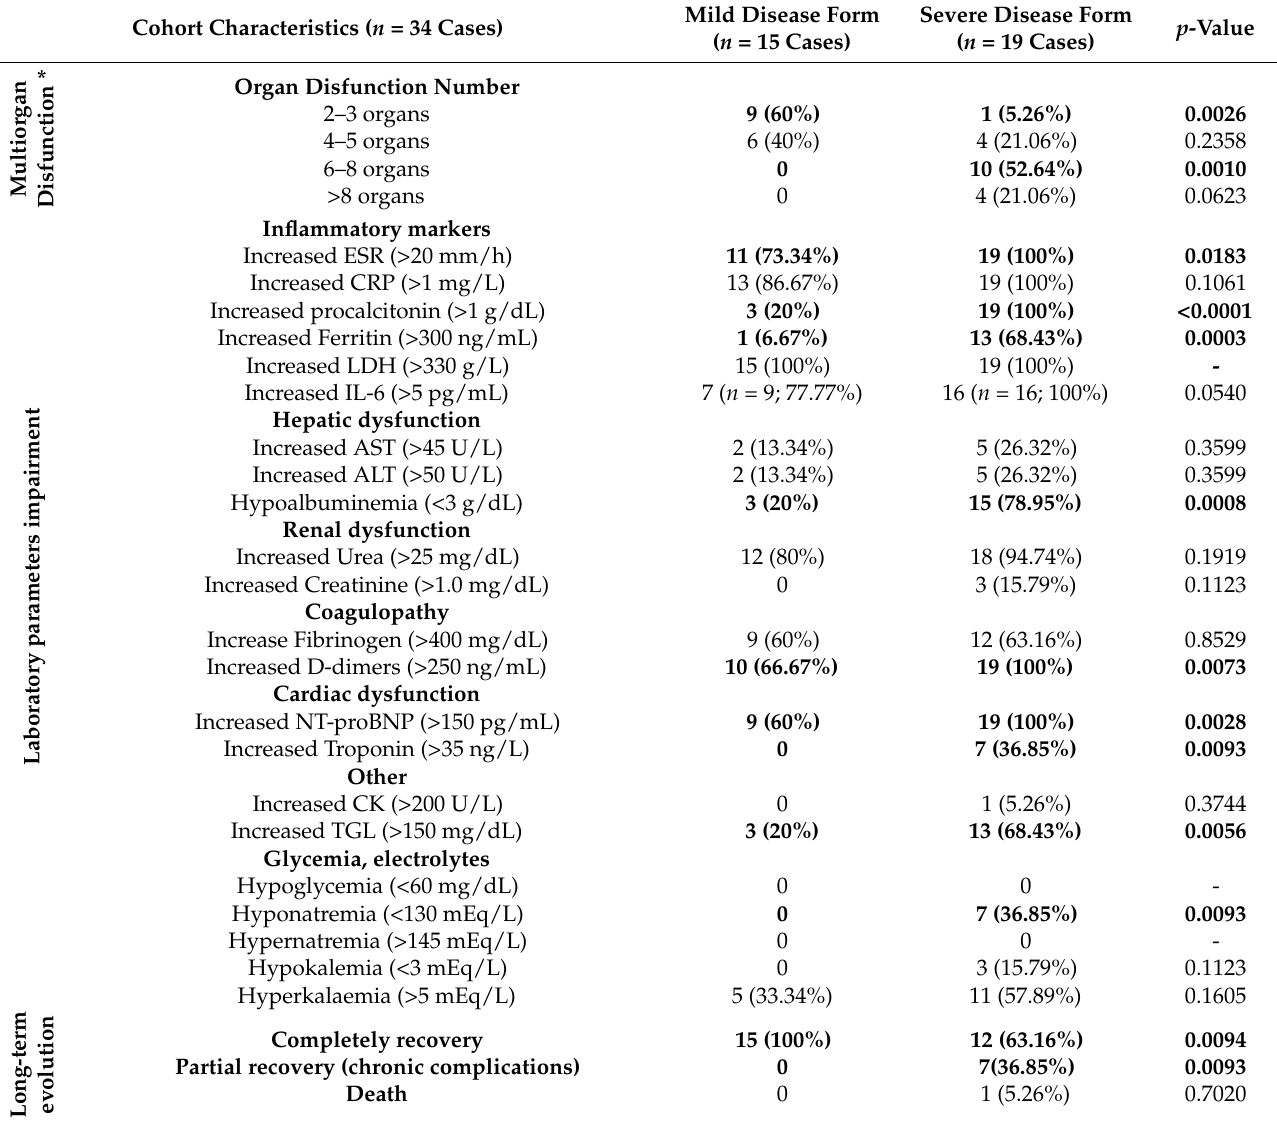
Table 3. Organ and tissues injuries in